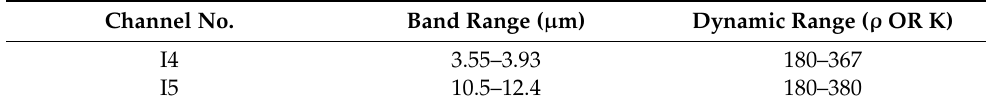
Table 1. Spectral and spatial characteristics of VIIRS channels. Channel